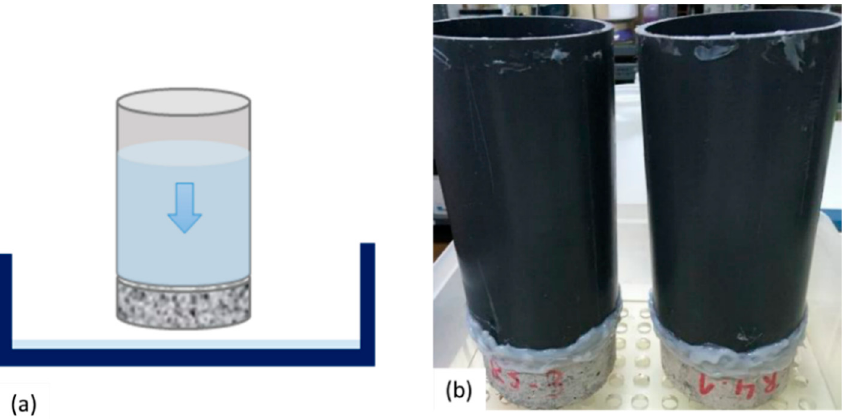
Figure 4. Water permeability setup measured with falling head setup; ( a ) graphical representation of setup and ( b ) experimental setup used.